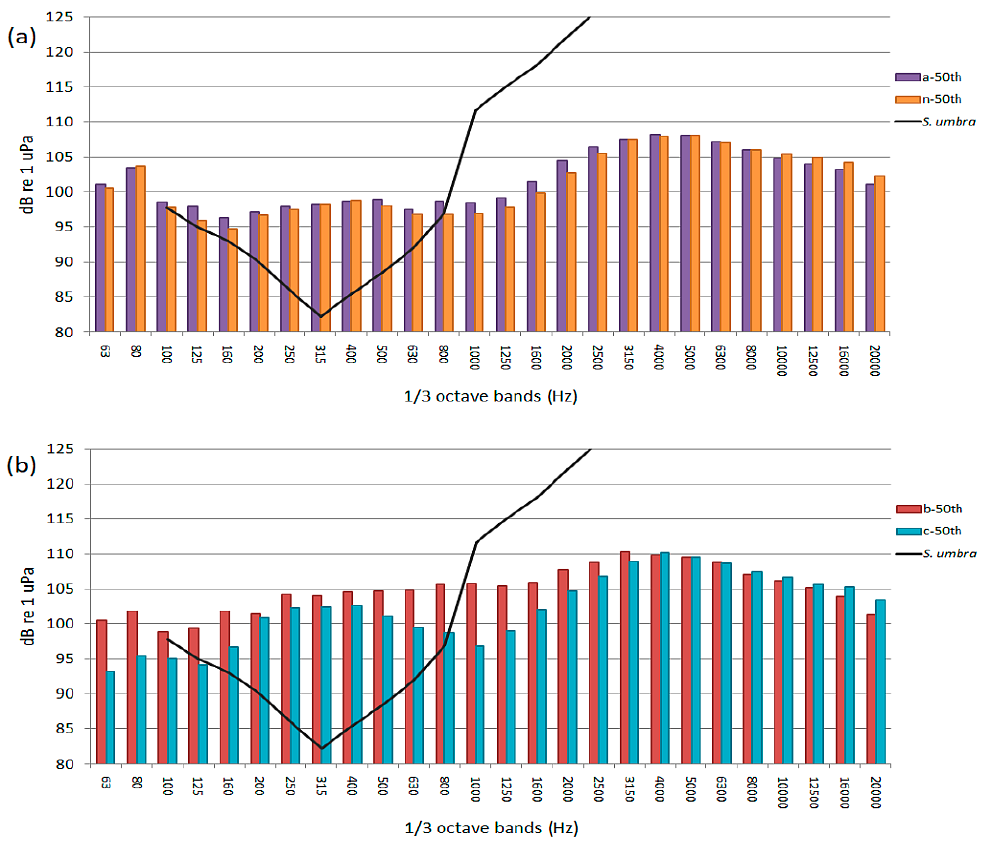
Figure 4. One-third octave band levels (median) related to ( a ) the afternoon (a-50th; 17–19, sample size of n = 80) and night (n-50th; 19.30–23, sample size of N = 80) recordings; ( b ) the afternoon recordings containing three or more boat (b-50th; sample size of N = 31) passages and the nocturnal Sciaena umbra chorus (c-50th; sample size of n = 11). The levels are compared to the Sciaena umbra audiogram; noise above the audiogram lines is expected to be audible.